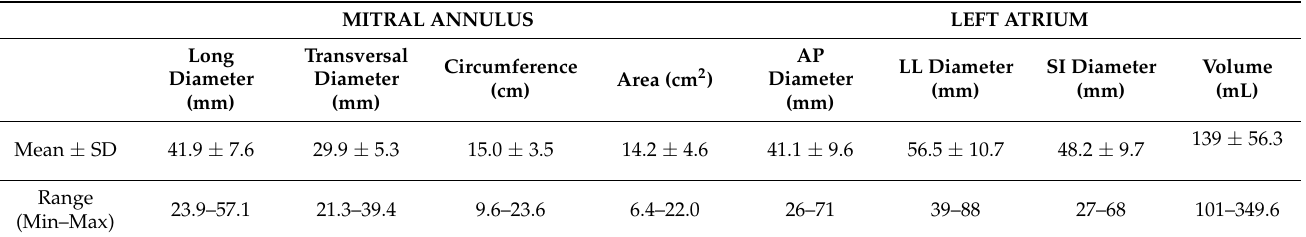
Table 1. Means and standard deviation for mitral annulus and left atrial dimensions.